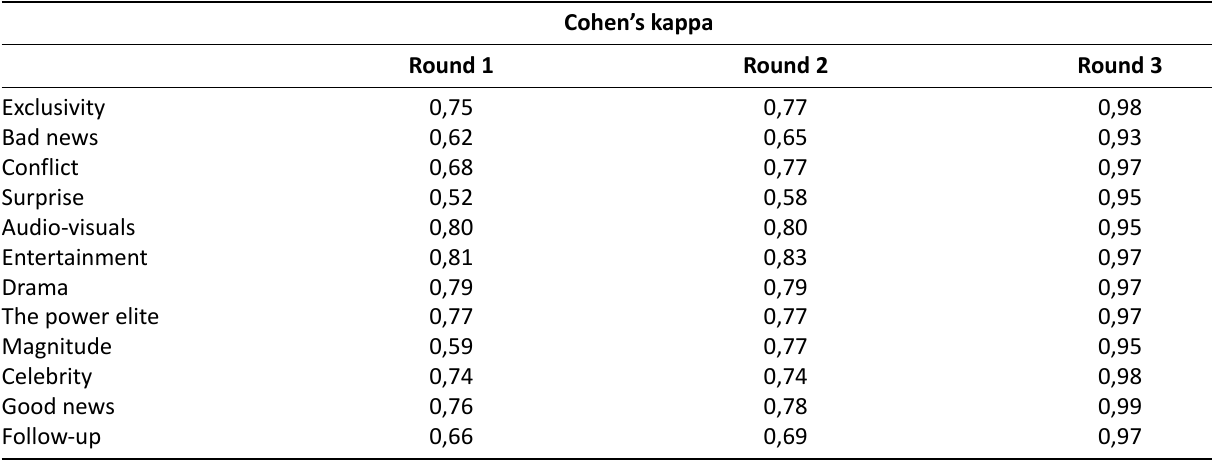
Table 1. Cohen’s